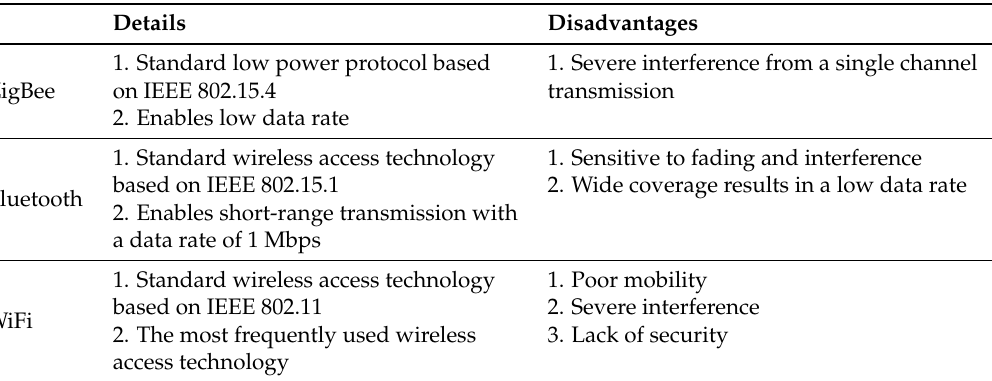
Table 1. Comparison of the conventional wireless access solutions for MTC